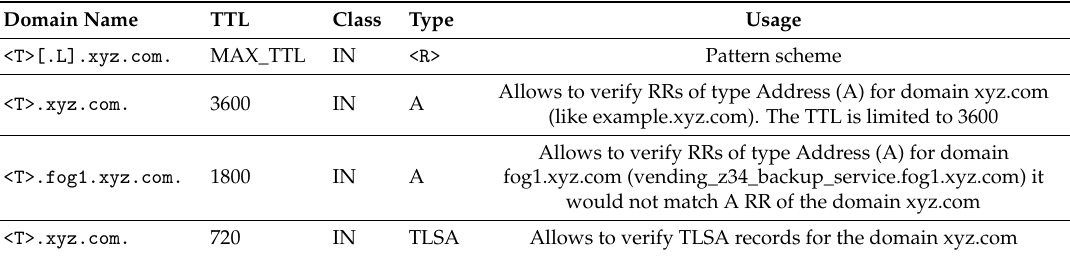
Table 2. Example of pattern record with placeholders and usage